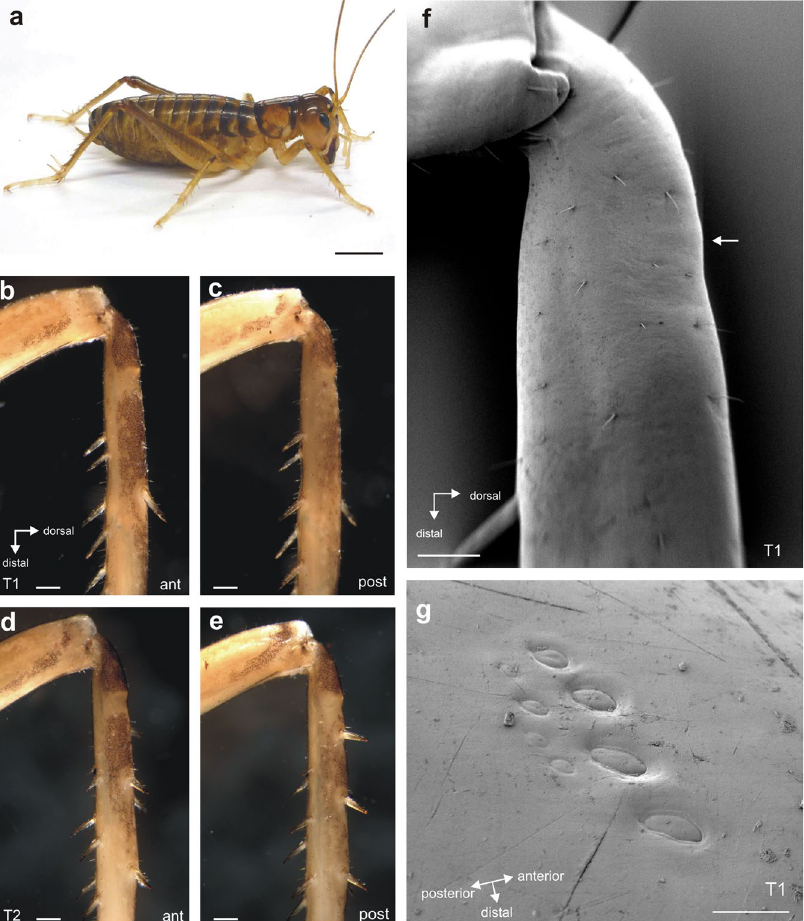
Figure 1. Hemiandrus pallitaris and external leg morphology. ( a ) Female individual of H. pallitarsis . Photograph by J. Strauß. Forelegs lack tympanal membranes on the anterior ( b ) or posterior face ( c ), and are similar to the midlegs ( d , e ). Note the proximal tibial areas with less pigmentation on both sides of the leg. Cuticle is generally solid with no vestiges of tympanal membranes, seen in the scanning electron micrograph ( f ). White arrow indicates the location of campaniform sensilla shown in ( g ). ( g ) Two rows of campaniform sensilla are located on the dorsal foreleg. Abbreviations: ant, anterior; post, posterior. Scales: ( a ) = 7.5 mm. ( b – e ) = 500 µ m; ( f ) = 250 µ m; ( g ) = 20 µ